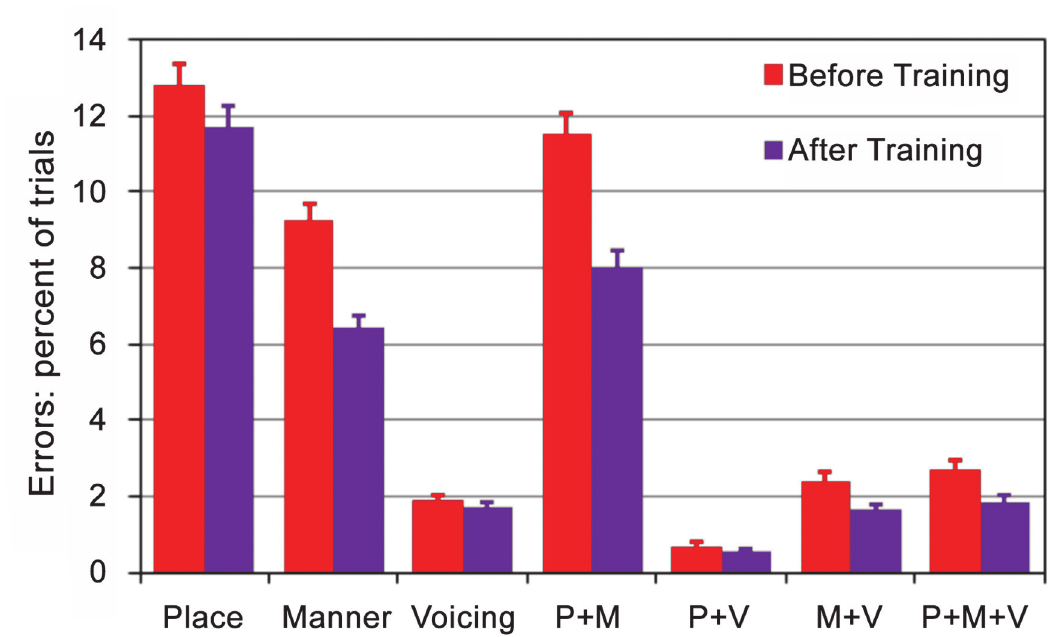
Fig 8. Training benefit on different types of phonetic errors. Error bars show standard